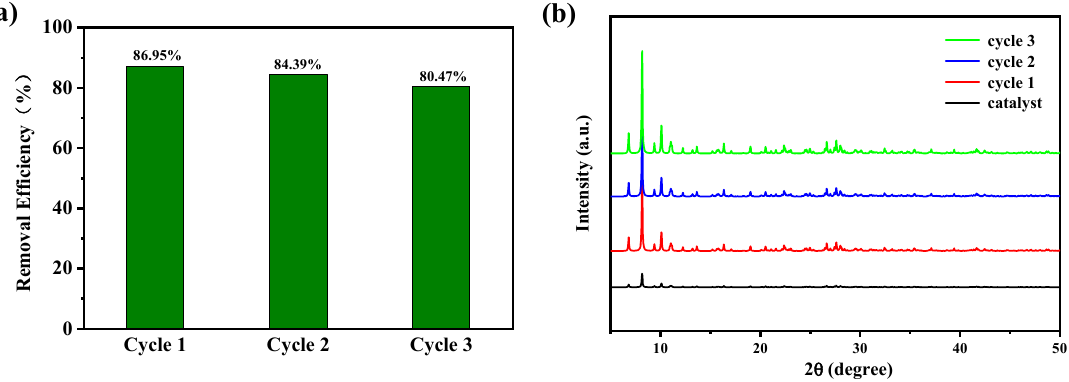
Figure 10. ( a ) Cycle test of compound 1 to degrade CIP at 30 °C, ( b ) PXRD patterns of compound 1 before and after the catalytic reaction.